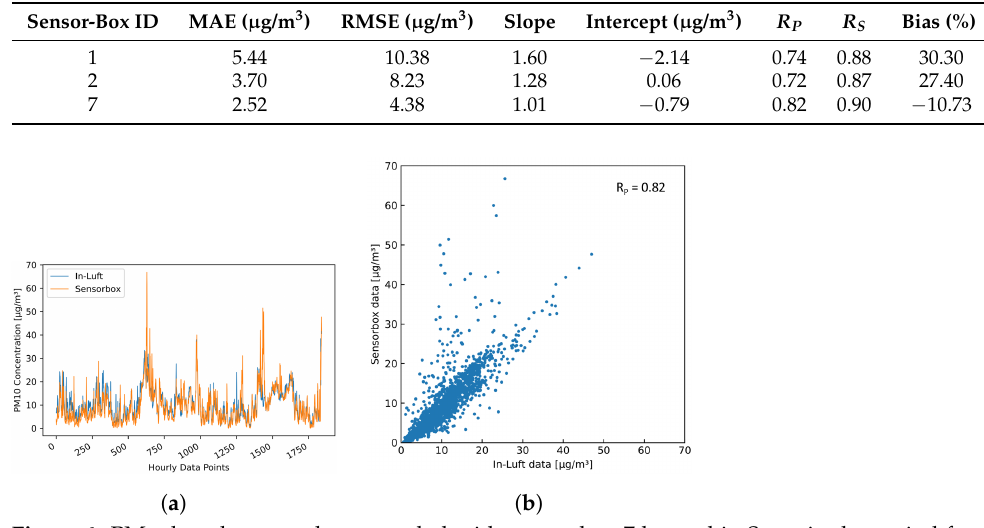
Figure 6. PM 10 hourly mean data recorded with sensor-box 7 located in Stans in the period from 15 October 2021 to 31 December 2021, compared to hourly mean data recorded at the in-luft station located in Stans. Fixed-percentile (Filter 2, 99.0%) applied to sensor-box data. N = 1843, R P = 0.82, R S = 0.90 ( a ) time series; ( b ) scatter plot.